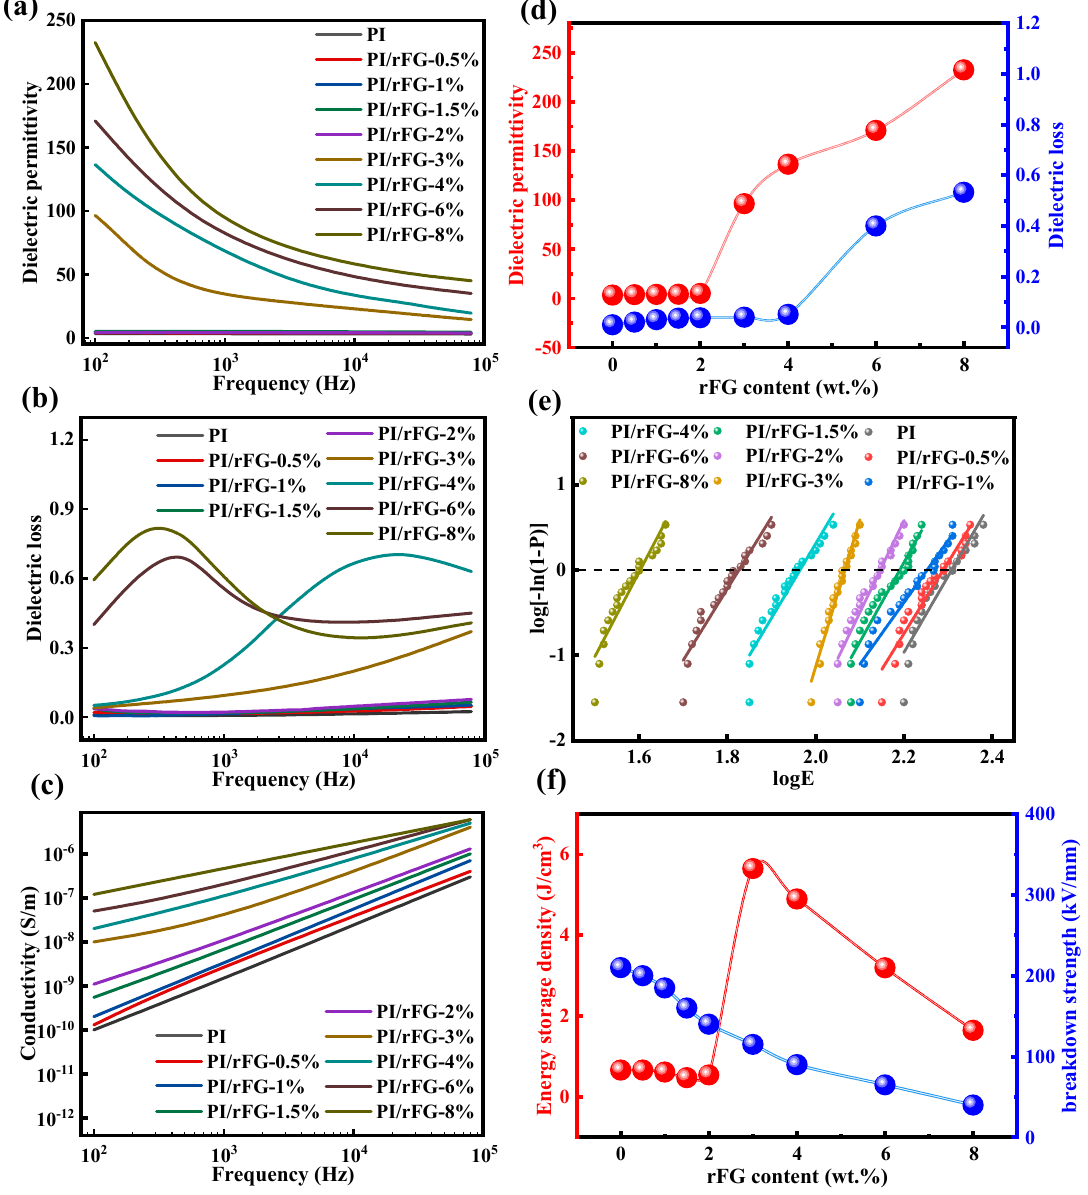
Figure 4. Dielectric property of PI/rFG composites films. ( a ) Curves of dielectric permittivity of the PI/rFG composite films with frequency; ( b ) curves of dielectric loss of the PI/rFG composite films with frequency; ( c ) curves of conductivity of the PI/rFG composite films with frequency; ( d ) dielectric permittivity and dielectric loss of the various PI/rFG composite films at 100Hz; ( e ) the Weibull distribution of dielectric breakdown strength of the PI/rFG composite films; ( f ) energy storage density and breakdown strength of the PI/rFG composite films. Table 2. The dielectric properties of various PI composite films.